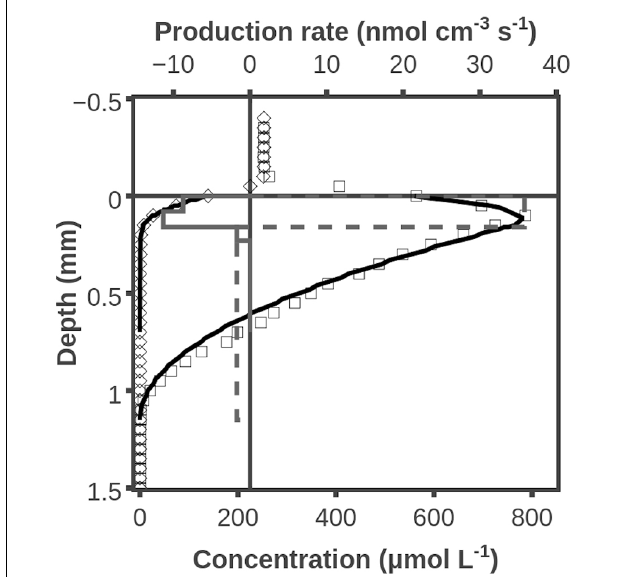
FIGURE 1 | Example of O 2 concentration profile and O 2 production rates under dark- and light conditions. Shown are measured O 2 concentrations during darkness ( (cid:5) ) and illumination ( (cid:3) ). Also shown are modeled O 2 concentration profiles ( –––– ), assuming transformation rates (during darkness: fully drawn box diagram; during illumination: with broken line) suggested by curve fitting. Data obtained by use of O 2